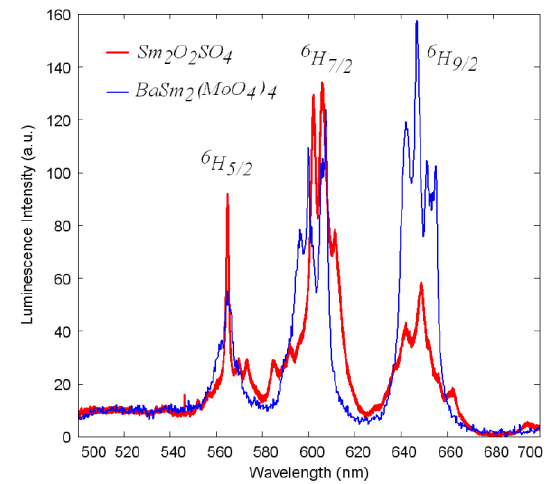
Figure 9. The luminescence spectra of Sm 2 O 2 SO 4 (red) and of the reference crystal (BaSm 2 (MoO 4 ) 4 , blue). For better comparison, the reference crystal spectrum is divided by 10.